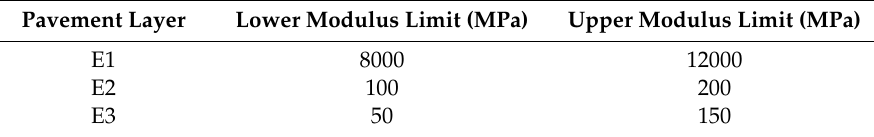
Table 4. Limit values of layer moduli defined for the back calculation.